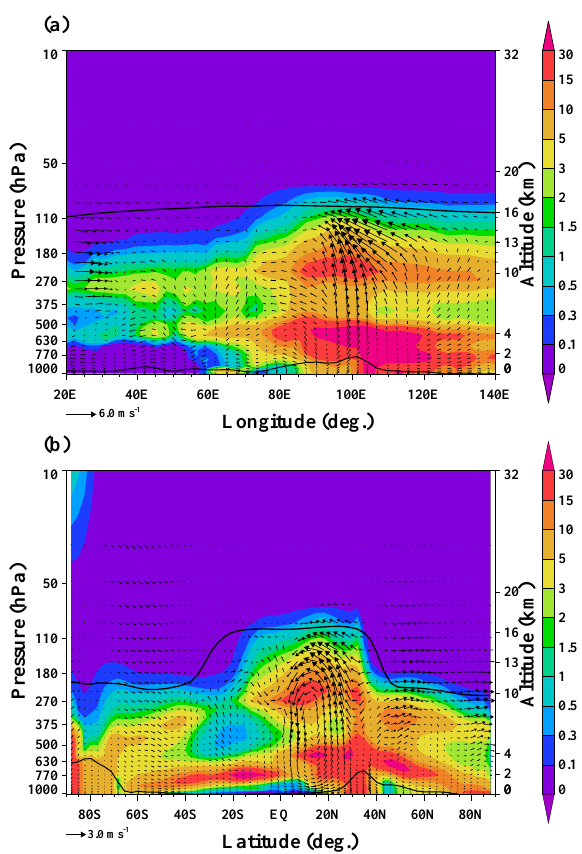
Fig. 4. Distribution of cloud droplet number concentration (CDNC) and ice crystal number concentration (ICNC) (1mg − 1 ) averaged for June–September 2003. (a) Latitude average between 20 and 30 ◦ N and (b) zonal average between 60 and 120 ◦